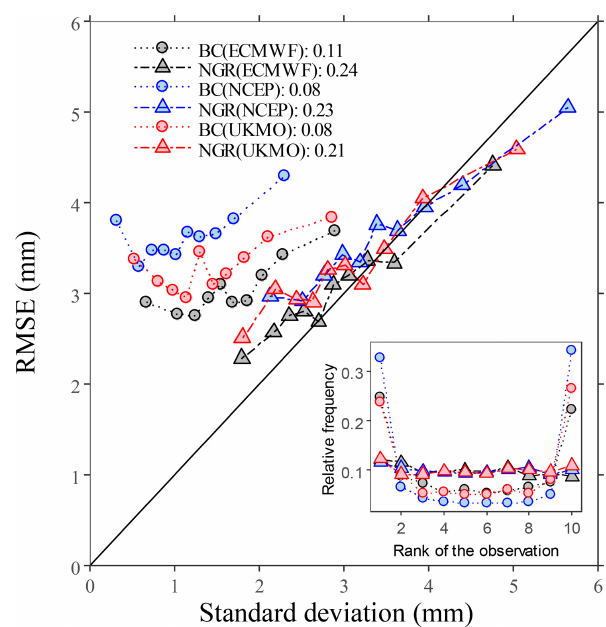
Figure 7. Binned spread–skill plots for the weekly forecasts ac- counting for the mean of the ensemble standard deviation deciles against the mean RMSEs of the forecasts in each decile over the verification period using all pairs of forecasts and observations. The inset panel shows the corresponding rank histograms. The correla- tion between the standard deviations and the absolute errors is in- cluded in the legend. The solid line represents the 1 : 1